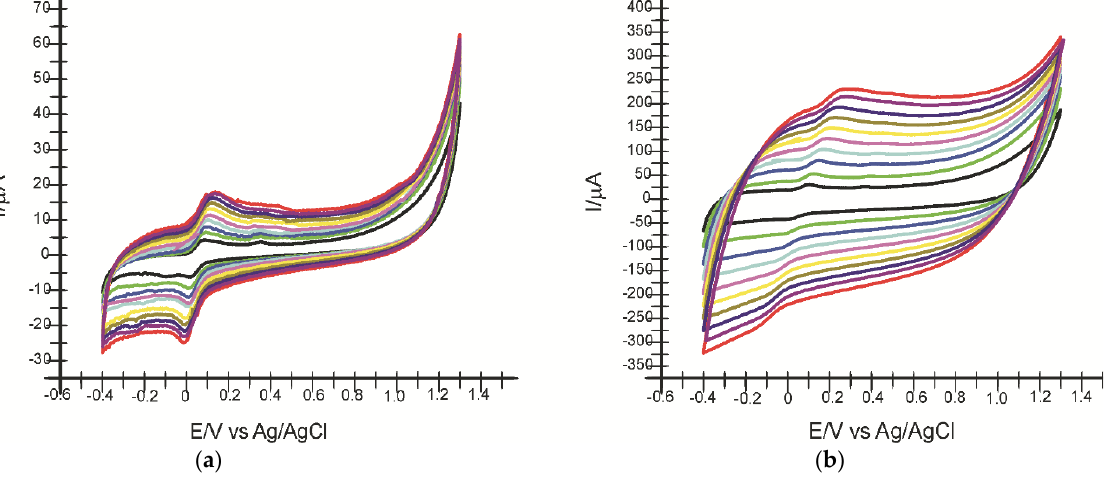
Figure 9. Cyclic voltammograms of SPE-SWCNT ( a ) and SPE-SWCNT-Ty ( b ) recorded at different